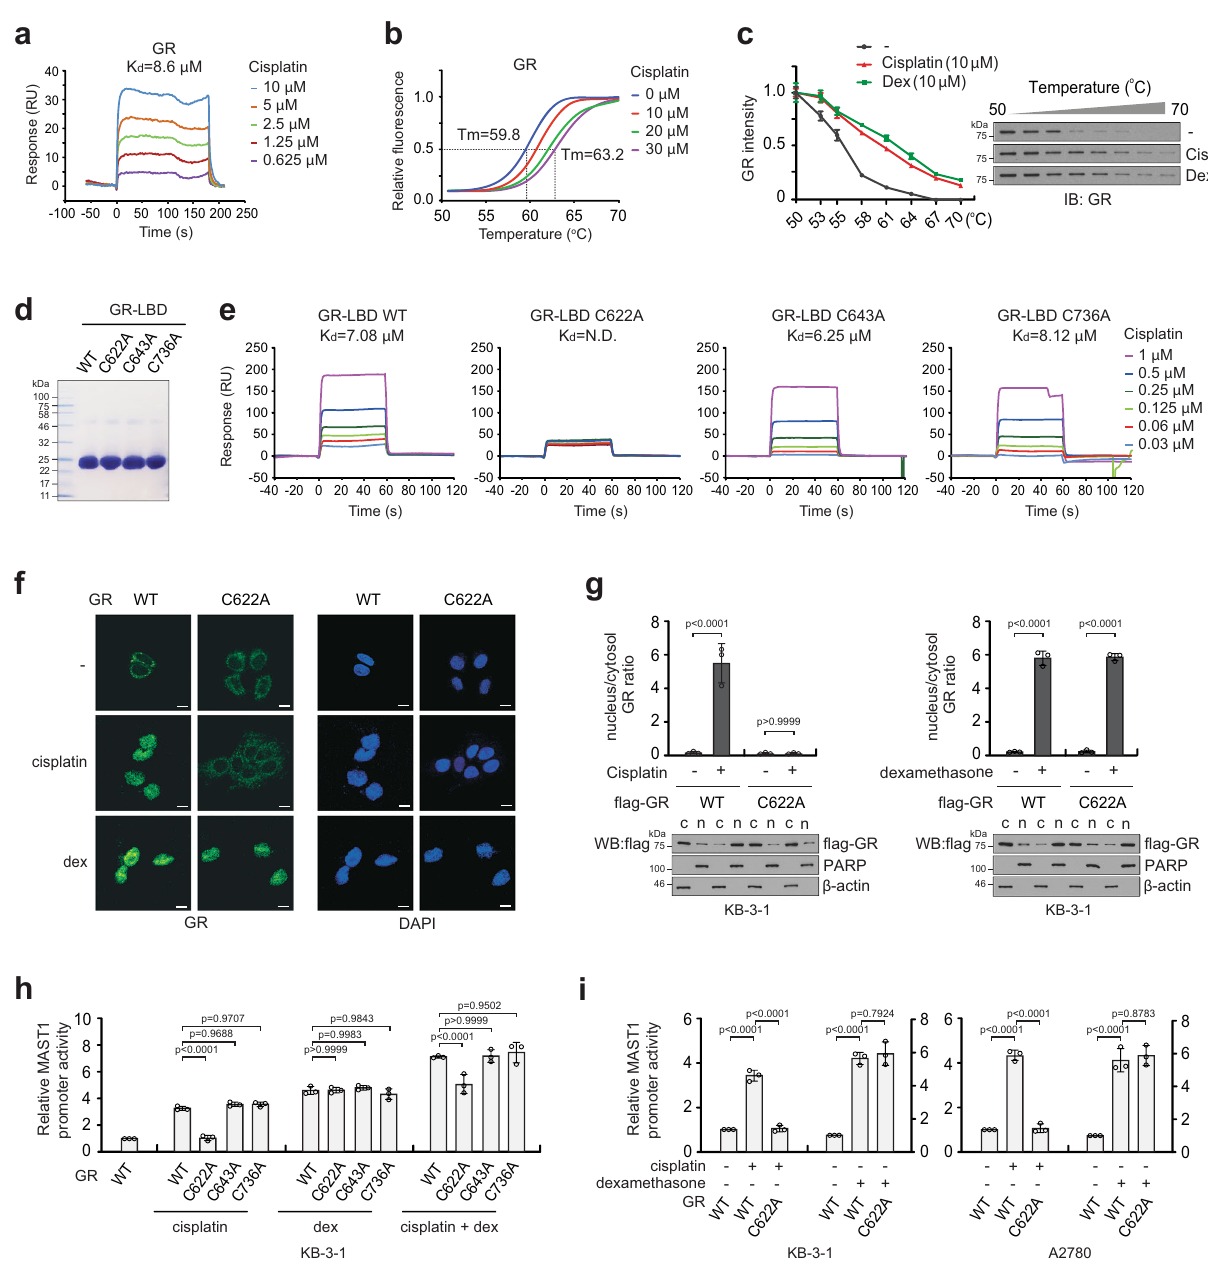
Fig. 4 Cisplatin binds to C622 in GR that mediates nuclear translocation and transcriptional activation. a Interaction between GR and cisplatin was determined by surface plasmon resonance (SPR) analysis and shown as a dissociation constant value. GR protein was enriched from 239T cells carrying pLHCX- fl ag-GR. b Differential scanning fl uorimetry of GR incubated with increasing concentrations of cisplatin. c Cellular thermal shift assay using KB-3-1 cells treated with vehicle, cisplatin, or dexamethasone. d Coomassie-stained SDS-PAGE gel of puri fi ed recombinant GR ligand-binding domain variants, GR- LBDm WT, C622A, C643A, and C736A. e Interaction between GR-LBDm variants and cisplatin is determined by SPR analyses. f , g Effect of cisplatin and dexamethasone on GR nuclear translocation in KB-3-1 expressing GR WT or C622A mutant. KB-3-1 cells were treated with 1 μ g/ml cisplatin or 500 nM dexamethasone for 24 h followed by immuno fl uorescence assay ( f ) or nuclear/cytosol fractionation ( g ). β -actin and PARP were used as cytoplasmic and nuclear markers, respectively. c: cytosol, n: nucleus. Scale bars represent 10 μ m. h , i Effect of cisplatin and dexamethasone on MAST1 promoter activity in KB-3-1 expressing GR WT or CA mutants ( h ) or in KB-3-1 and A2780 cells expressing GR WT or C622A mutant ( i ). Compounds were administered as described in f . Data are from one biological experiment for a , and mean ± SD from three independent biological experiments for the others. Statistical analyses were performed by one-way ANOVA for g – i . Source data are provided as a Source Data fi